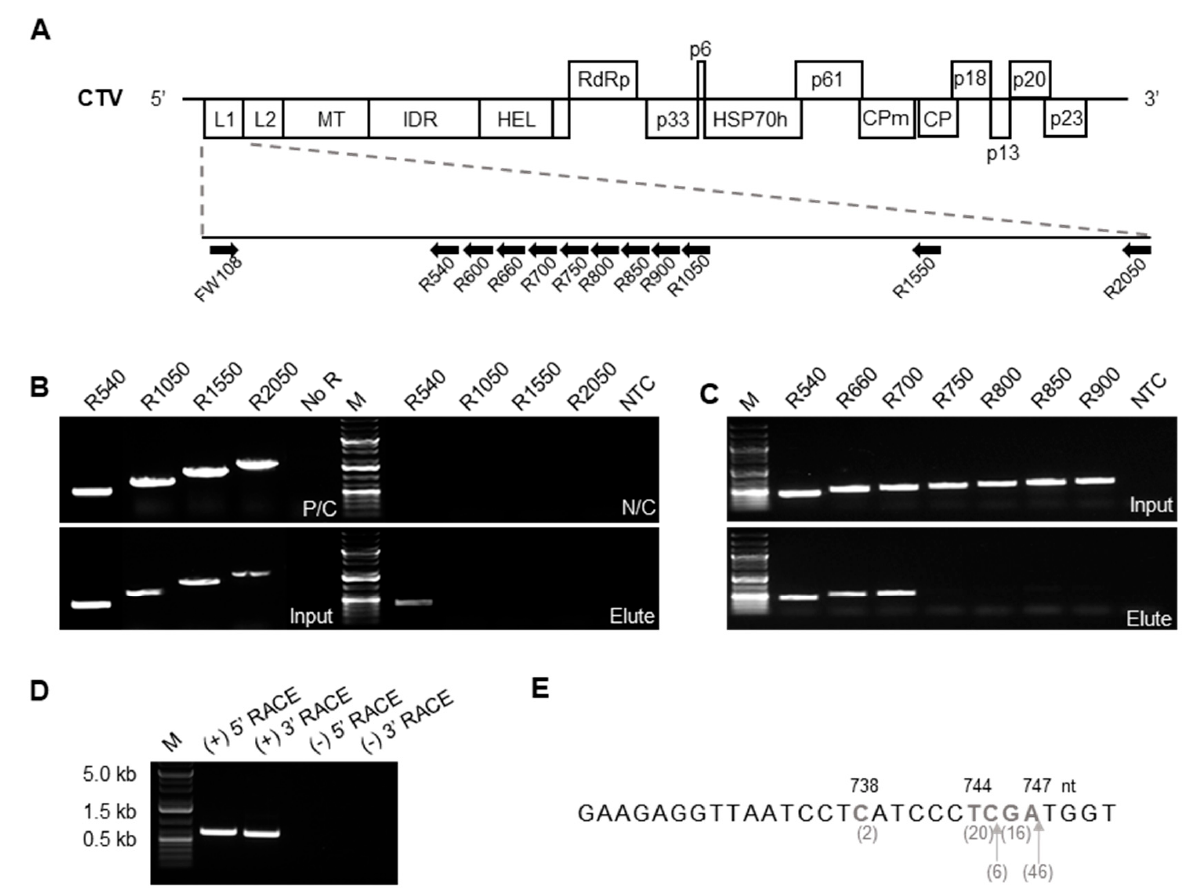
Figure 2. RNA molecule bound to the p33 protein is produced from the 5 ′ end of the CTV genome. ( A ) Schematic representation of the CTV genome and the positions of primers used in the RT-PCR analysis (shown in ( B , C )). FW108 is a forward primer that corresponds to the nt position 108 in the CTV genome. Reverse primers (R) are named according to the nt positions they bind to the CTV genome (see Supplementary Table S1). ( B ) RT-PCR products of primer sets shown in ( A ) were analyzed by agarose gel electrophoresis. Molecular weight marker (M) has three bright bands indicating fragments of 0.5, 1.5, and 5.0 kb from the bottom to the top, respectively (as shown in ( D )). P/C, RT-PCR using total RNA extract from CTV-infected tissue as a template. N/C, RT-PCR using water template. Input, see Figure 1B. Elute, total RNA extracted from the GFP-Trap beads at the completion of RIP assay (see Section 2). ( C ) RT-PCR products of primer sets shown in ( A ) were analyzed by agarose gel electrophoresis (continued from ( B )). The image shows that the amplification no longer occurs with reverse primers annealing beyond 750 nt position of the CTV genome. “Input” and “Elute” are described in ( B ). ( D ) 5 ′ and 3 ′ RACE for positive- and negative-stranded RNA using “Elute” RNA analyzed by agarose gel electrophoresis. Each amplified product shown in (+)5 ′ RACE and (+)3 ′ RACE lanes was excised from the gel and cloned for sequencing. RACE reaction targeting negative-strands ((-)5 ′ RACE and (-)3 ′ RACE) produced no amplification. ( E ) The 3 ′ end sequence of (+)3 ′ RACE products determined by sequencing is shown. 46 out of 90 clean reads (out of 100 clones) ended at 747 nt position of the CTV genome. 16, 6, 20, and 2 reads ended at 746, 745, 744, and 738 nt positions, respectively. NTC, no template control.